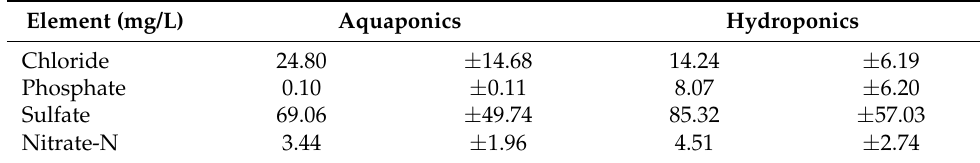
Concentrations of chloride Cl − , nitrate-N NO 3 -N, sulfate SO 42 − , and phosphate PO 4 3 − (mg/L) in water samples taken on the last day (day 42) of the experiment in aquaponics and hydroponics deep water culture units. For aquaponics treatment spinach ( Spinacia oleracea ) was grown in a coupled aquaponic system together with rainbow trout ( Oncorhynchus mykiss ). Element (mg/L) Aquaponics Hydroponics Chloride 24.80 ± 14.68 14.24 ± 6.19 Phosphate 0.10 ± 0.11 8.07 ± 6.20 Sulfate 69.06 ± 49.74 85.32 ± 57.03 Nitrate-N 3.44 ± 1.96 4.51 ± 2.74 Values are means ± SD, n = 3. There were no statistically significant differences between the treatments (indepen- dent sample t test, p > 0.05). Nitrite-N was below the LOD (0.13 mg/L) in both treatments. The concentration (mg/L) of chloride was higher ( p < 0.05) in the aquaponics